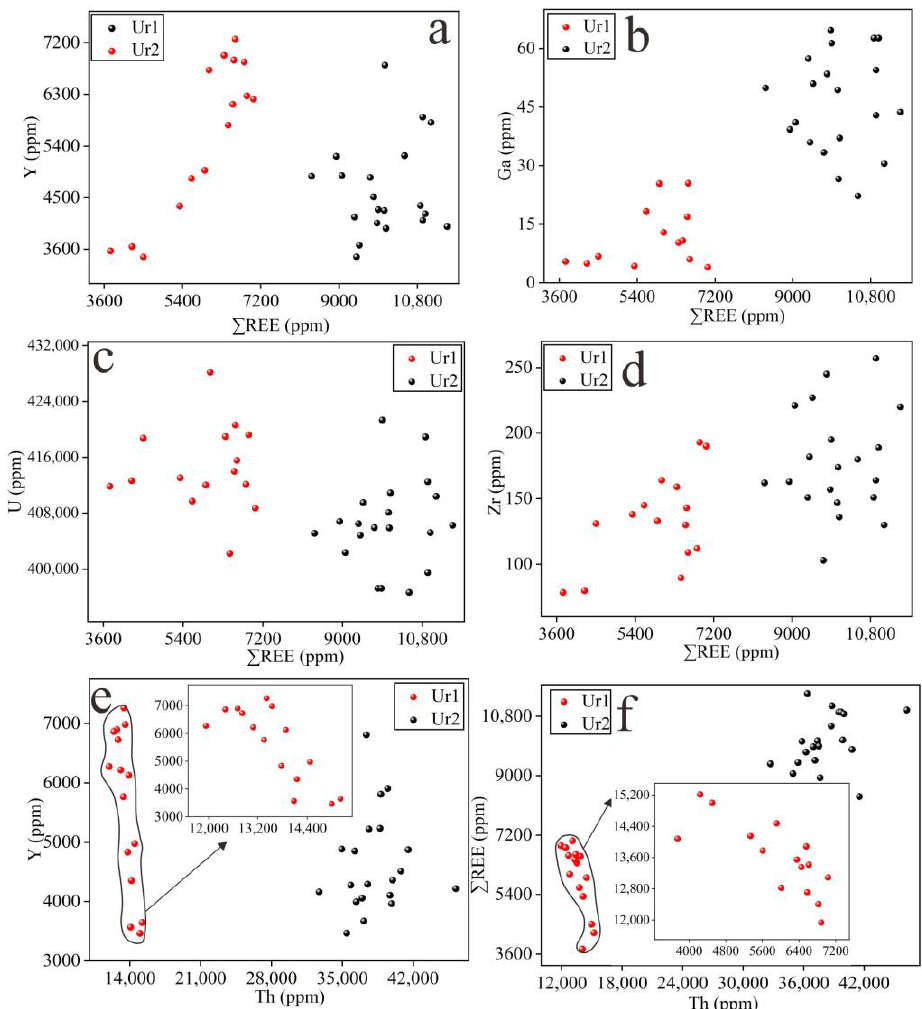
Figure 9. ( a – f ) Variations in the trace and rare earth element contents of the Ur1 and Ur2 uraninite in the Datian uranium deposit. the Datian uranium